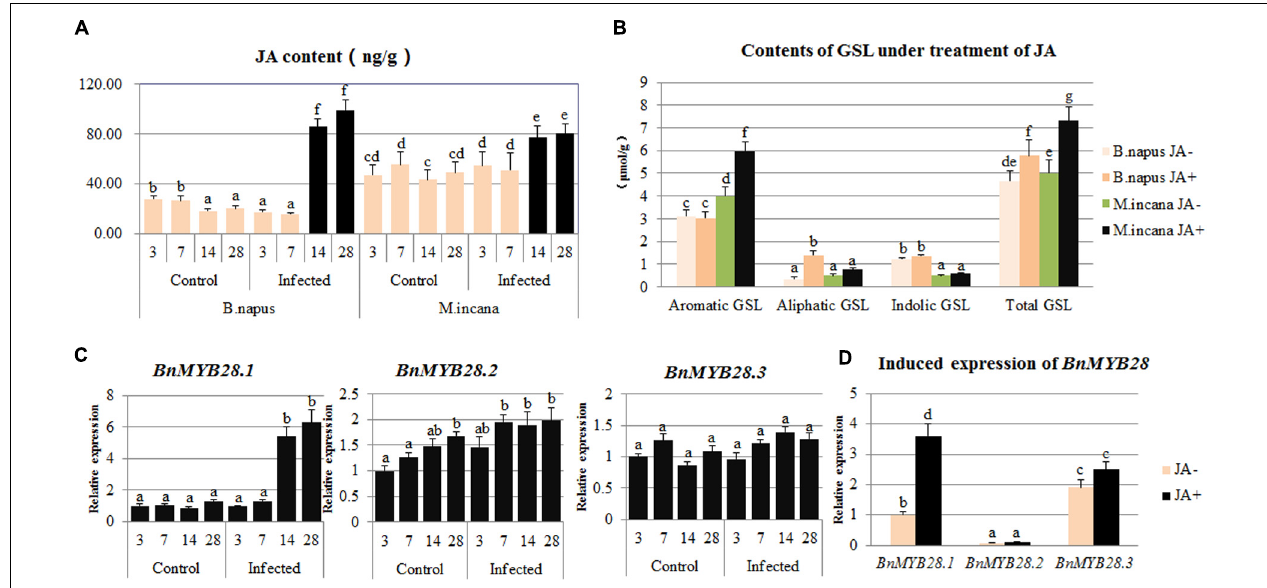
FIGURE 7 | Contents of jasmonic acid (JA) in clubroot disease and induced content of glucosinolates (GSLs) and expression of BnMYB28 by the exogenous JA treatment. (A) Contents of JA in clubroot disease. (B) Contents of GSL by exogenous JA treatment. (C) Expression of BnMYB28 in clubroot disease. (D) Induced expression of BnMYB28 by exogenous JA treatment. Error bars represent the standard errors of three independent experiments. Different letters above the bars indicate that the differences are significant ( P <